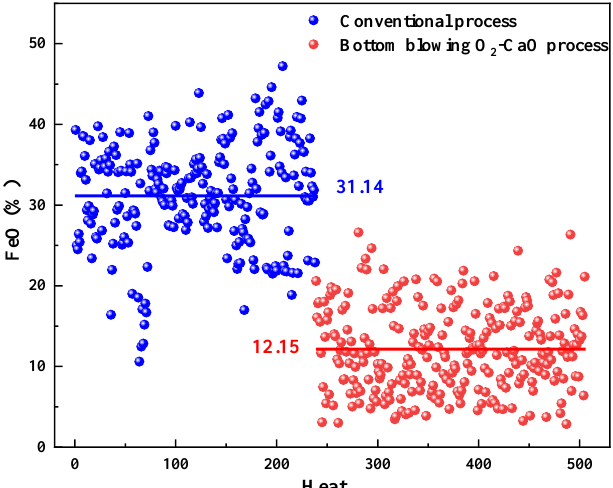
Figure 2. Comparison of FeO content in slag of conventional process and bottom-blowing O2-CaO process.